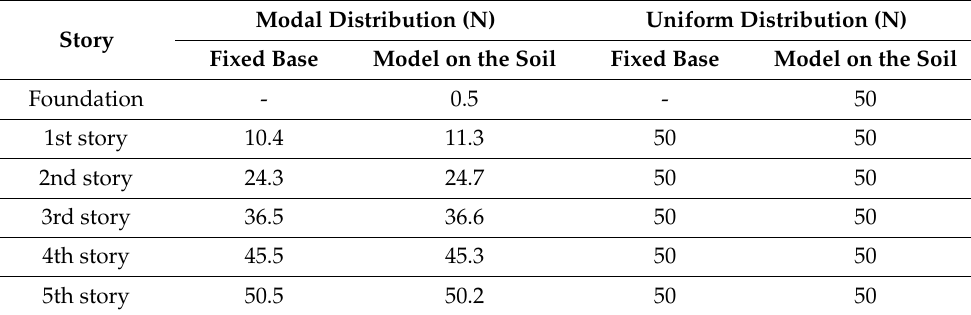
Table 3. Lateral load distributions for the moment resisting frame.